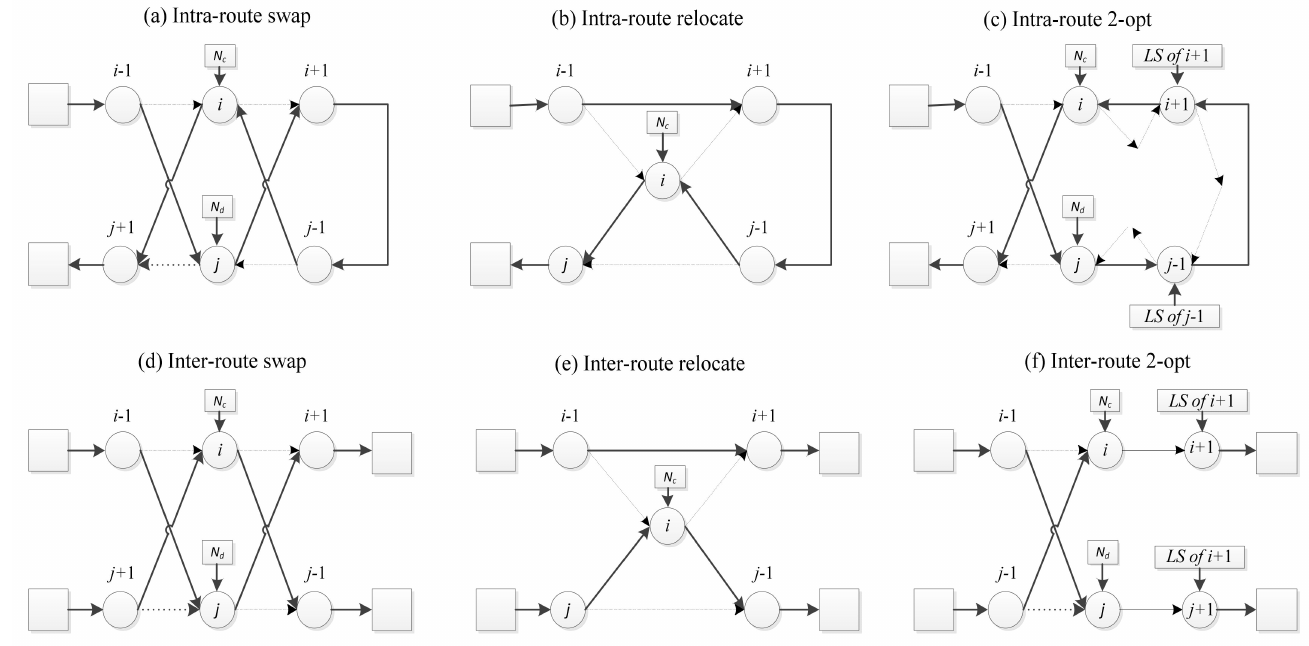
Figure 4. Six kinds of neighborhood